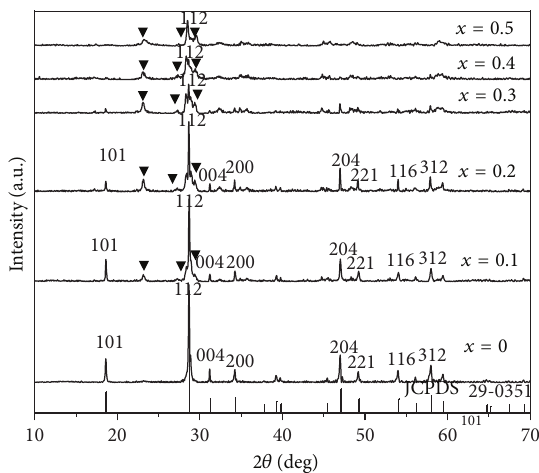
Figure 2: XRD patterns for (Ca 1−𝑥 , Gd 𝑥 )MoO 4 :0.05Eu 3+ ( 𝑥 = 0 , 0.1, 0.2, 0.3, 0.4, and 0.5) phosphors.